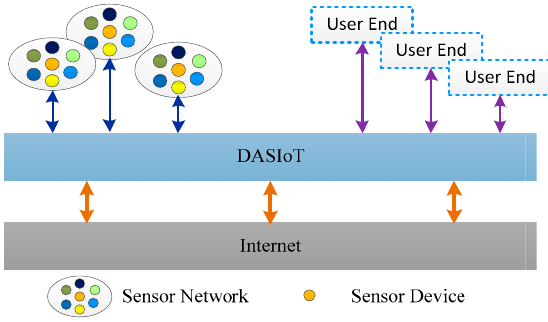
Figure 1. Structure of the integrated IoT system.